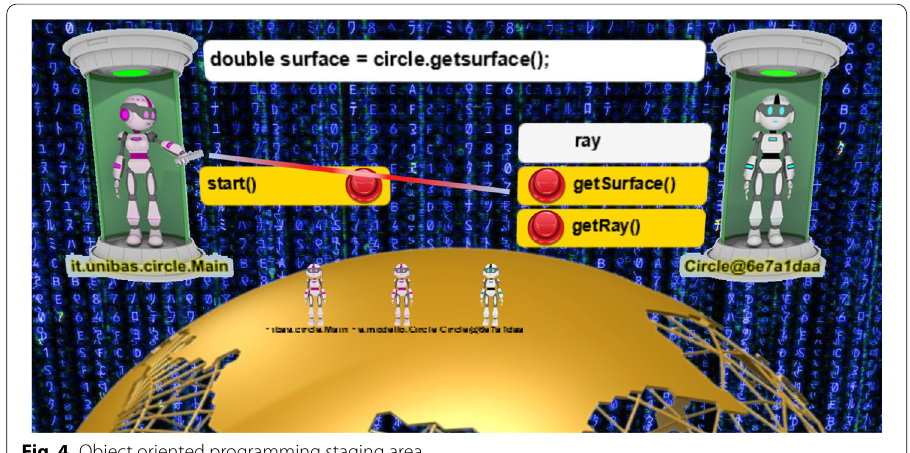
Fig. 4 Object oriented programming staging